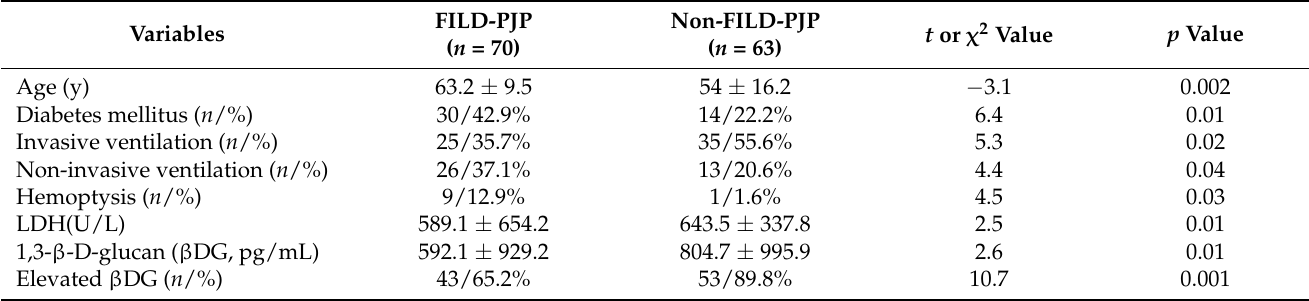
Table 5. The differences between FILD-PJP group and non-FILD-PJP group.